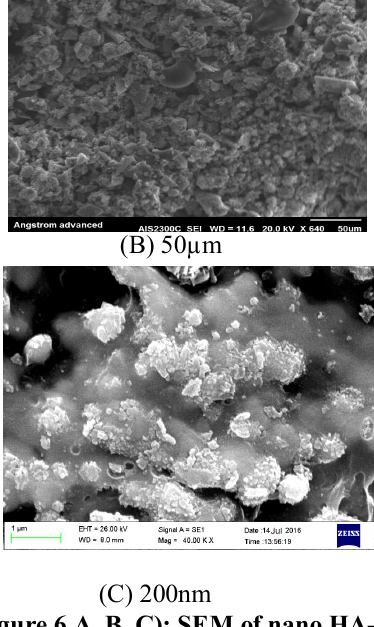
(Figure 6 A, B, C): SEM of nano HA- chitosan-collagen composite coating at different